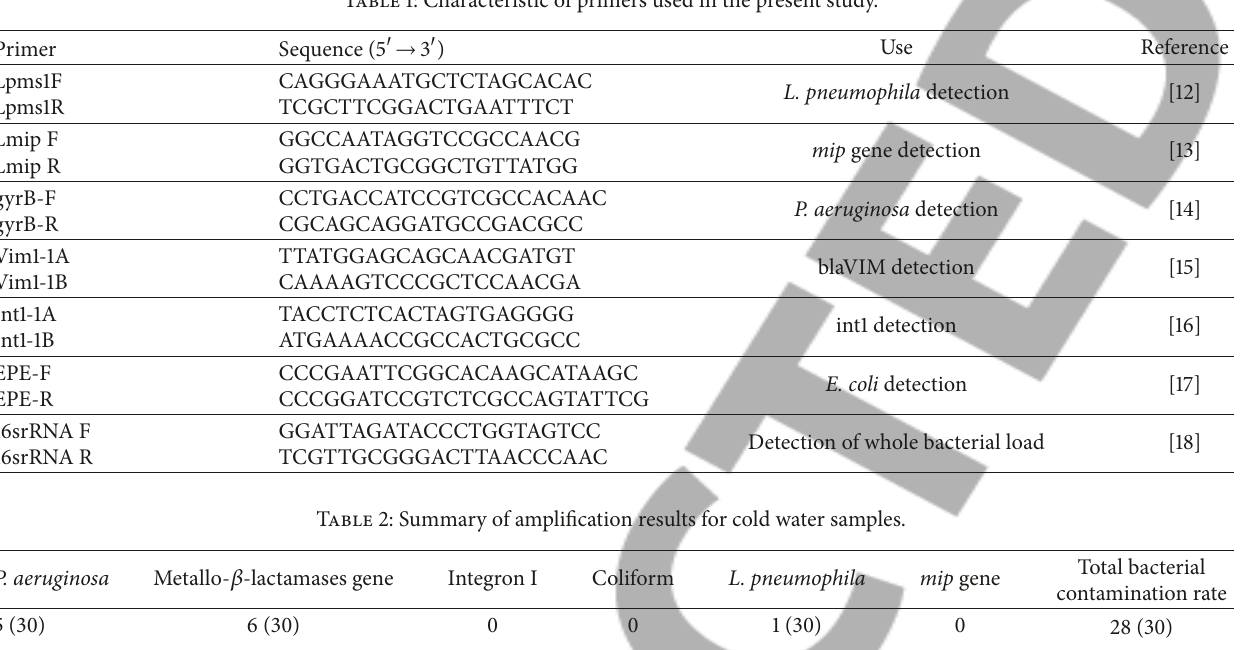
Table 1: Characteristic of primers used in the present study.